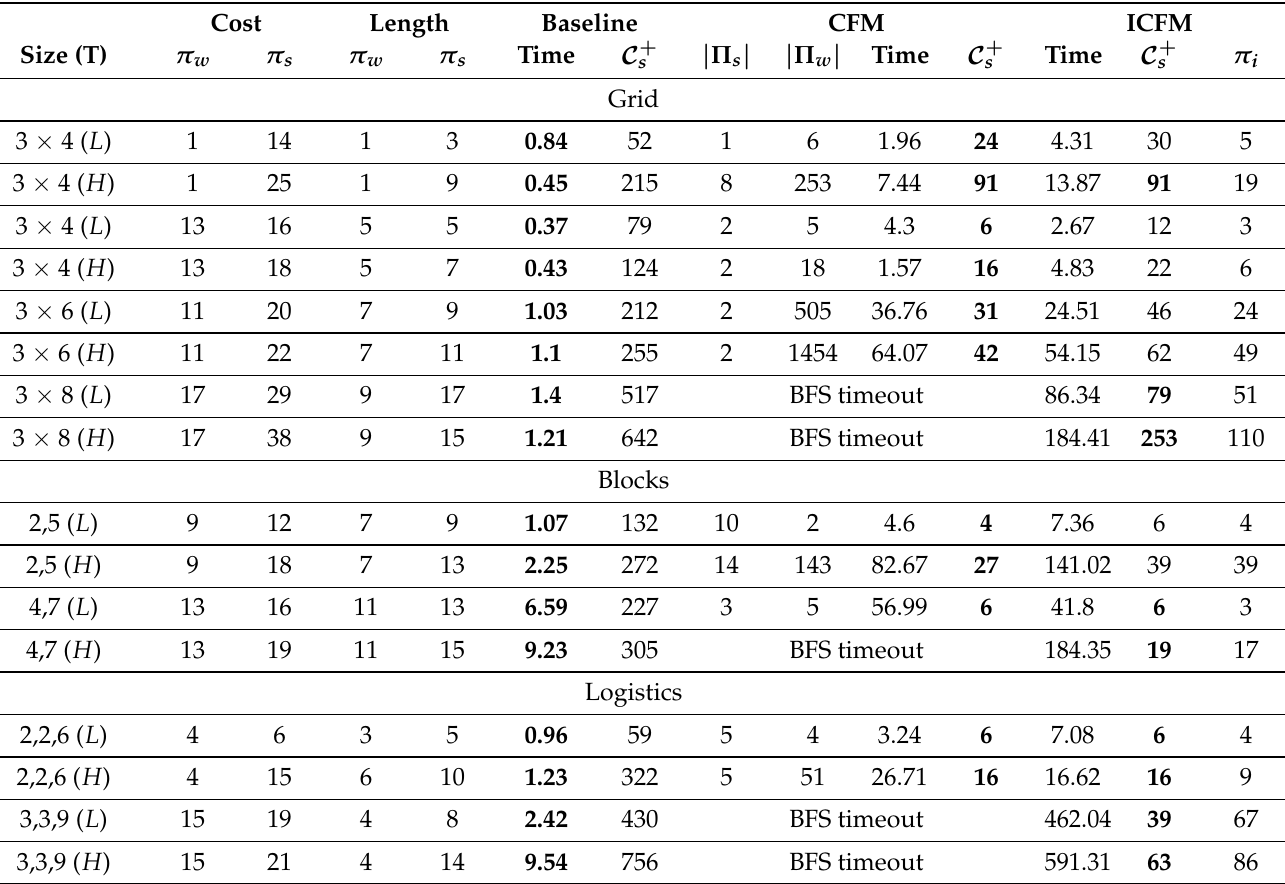
Table 1. Baseline and Incremental Cost Function Modification (ICFM) performance for different domain difficulty (H,L), and costs and plan lengths for π w and π s